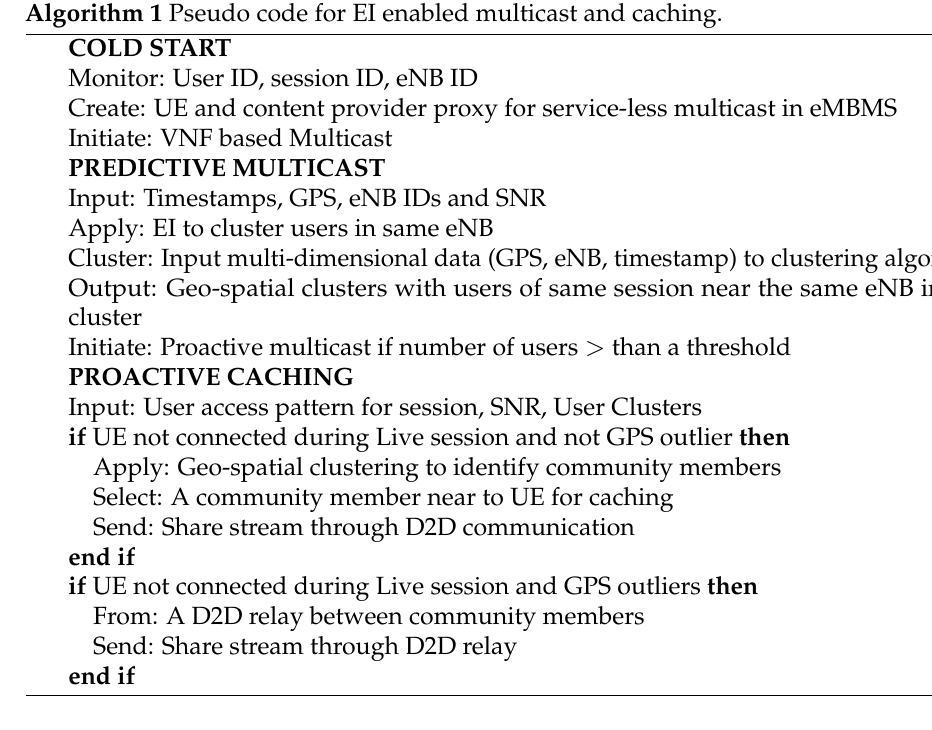
Algorithm 1 Pseudo code for EI enabled multicast and